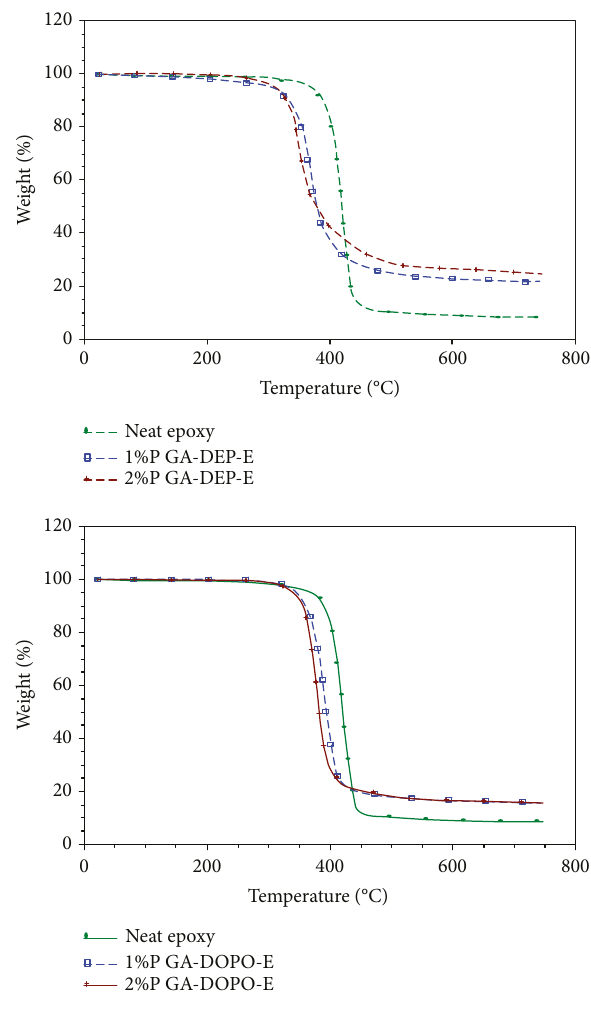
Figure 1: Thermal stability of blends of phosphorus esters of gallic acid anilide with DGEBA